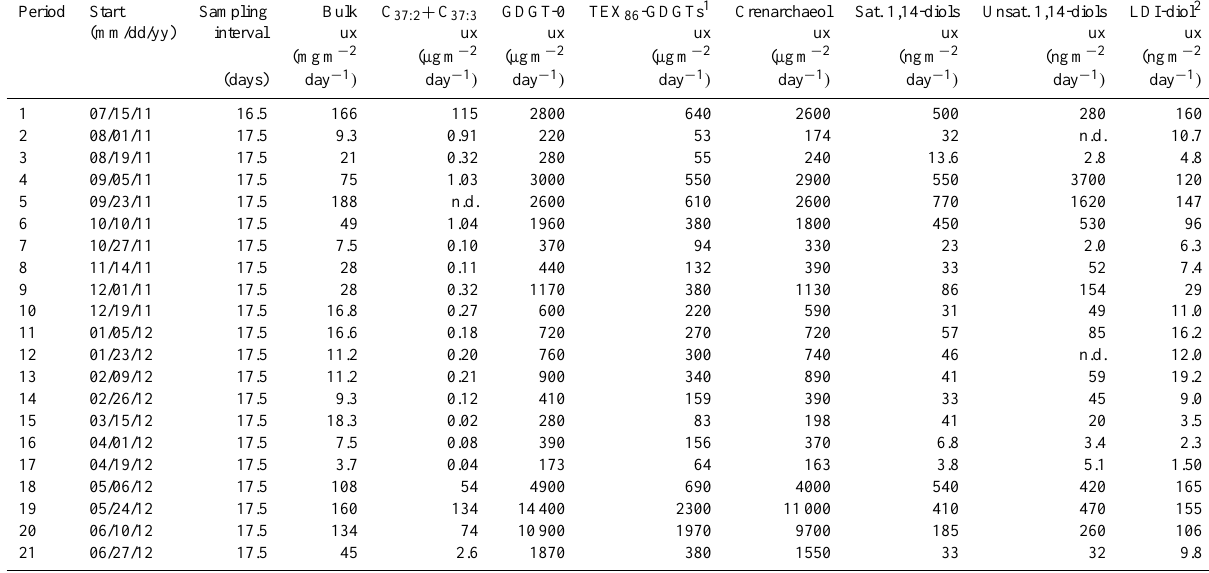
Table 2. Sampling intervals in the sediment trap and fluxes of lipids. For proxy values and derived temperatures, see Table S2. Period Start